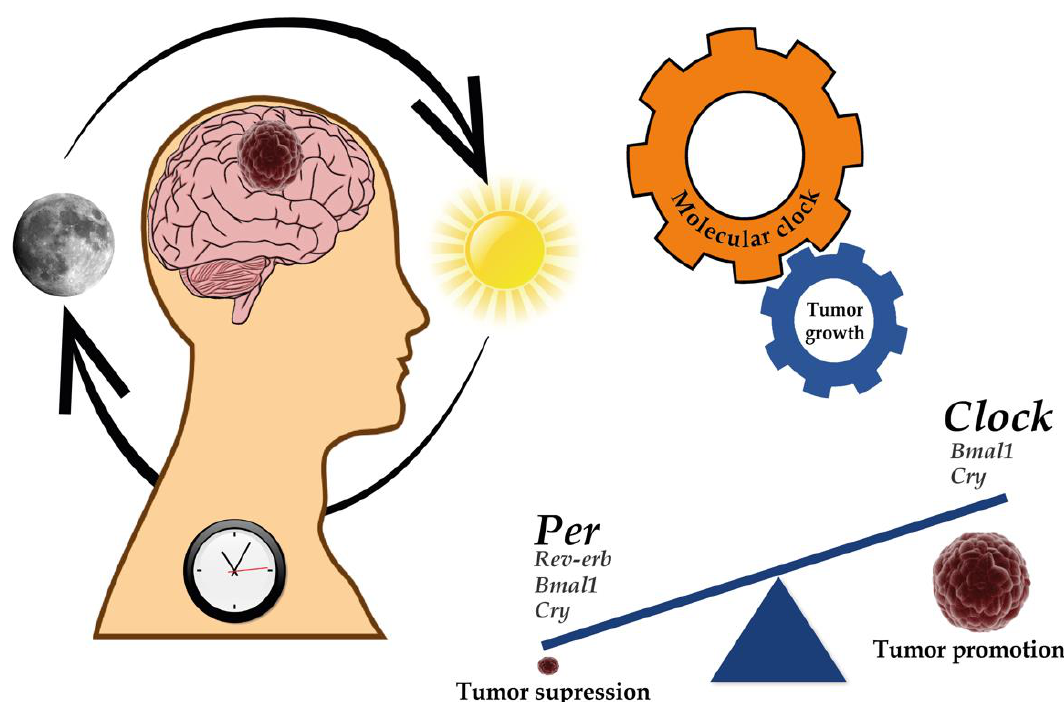
Figure 1. Implications of the circadian clock on cancer development and progression. Several genes of the molecular clock have been associated with both the regulation of GBM genesis and progression as well as tumor suppression. For further details, please see Table 3.